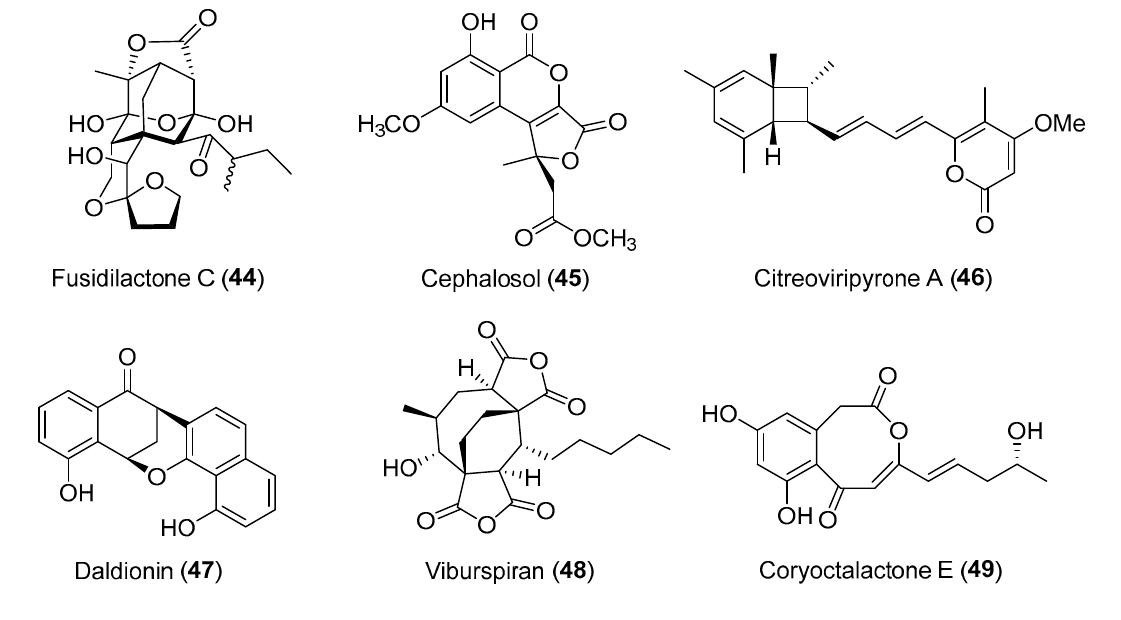
Figure 8. Structures of compounds 44 – 49 .